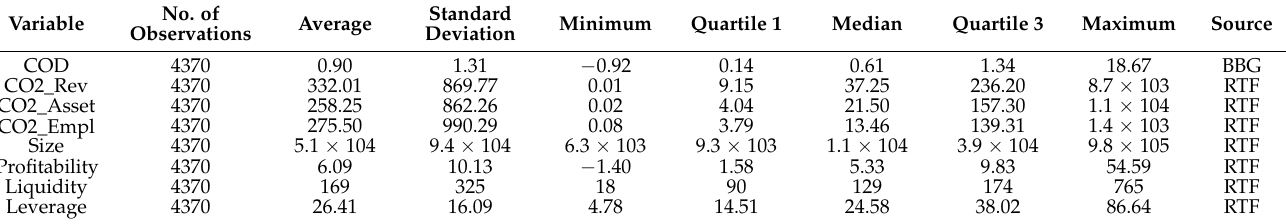
Table 2. Descriptive statistics for the variables applied in the